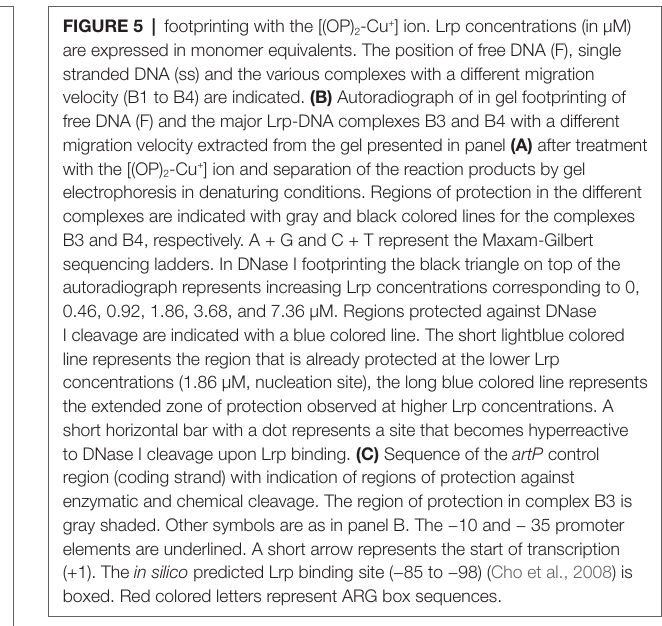
FIGURE 5 | footprinting with the [(OP) 2 -Cu + ] ion. Lrp concentrations (in μM) are expressed in monomer equivalents. The position of free DNA (F), single stranded DNA (ss) and the various complexes with a different migration velocity (B1 to B4) are indicated. (B) Autoradiograph of in gel footprinting of free DNA (F) and the major Lrp-DNA complexes B3 and B4 with a different migration velocity extracted from the gel presented in panel (A) after treatment with the [(OP) 2 -Cu + ] ion and separation of the reaction products by gel electrophoresis in denaturing conditions. Regions of protection in the different complexes are indicated with gray and black colored lines for the complexes B3 and B4, respectively. A + G and C + T represent the Maxam-Gilbert sequencing ladders. In DNase I footprinting the black triangle on top of the autoradiograph represents increasing Lrp concentrations corresponding to 0, 0.46, 0.92, 1.86, 3.68, and 7.36 μM. Regions protected against DNase I cleavage are indicated with a blue colored line. The short lightblue colored line represents the region that is already protected at the lower Lrp concentrations (1.86 μM, nucleation site), the long blue colored line represents the extended zone of protection observed at higher Lrp concentrations. A short horizontal bar with a dot represents a site that becomes hyperreactive to DNase I cleavage upon Lrp binding. (C) Sequence of the artP control region (coding strand) with indication of regions of protection against enzymatic and chemical cleavage. The region of protection in complex B3 is gray shaded. Other symbols are as in panel B. The −10 and − 35 promoter elements are underlined. A short arrow represents the start of transcription (+1). The in silico predicted Lrp binding site (−85 to −98) (Cho et al., 2008) is boxed. Red colored letters represent ARG box sequences.